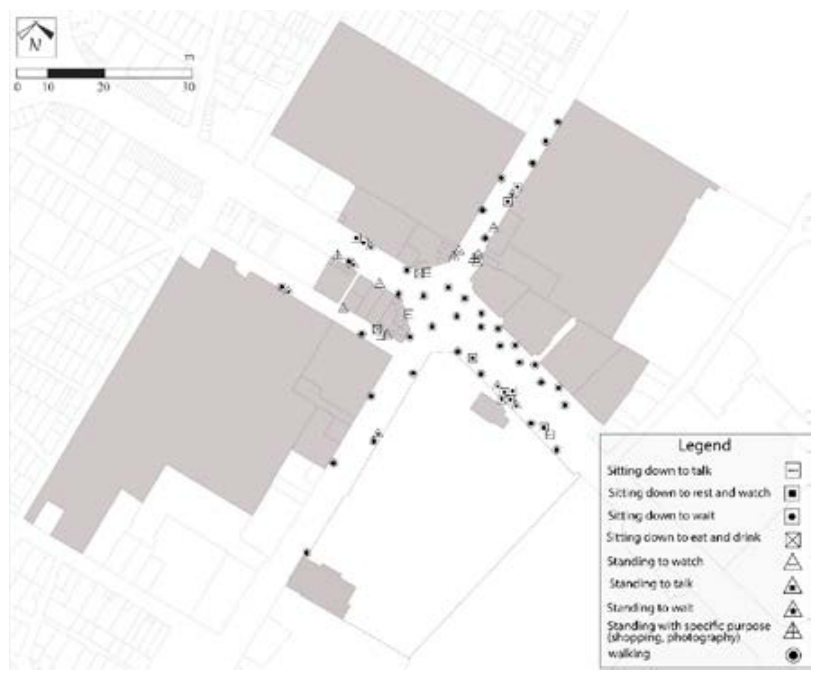
Fig. 8: Locations and types of activities (night); source: authors